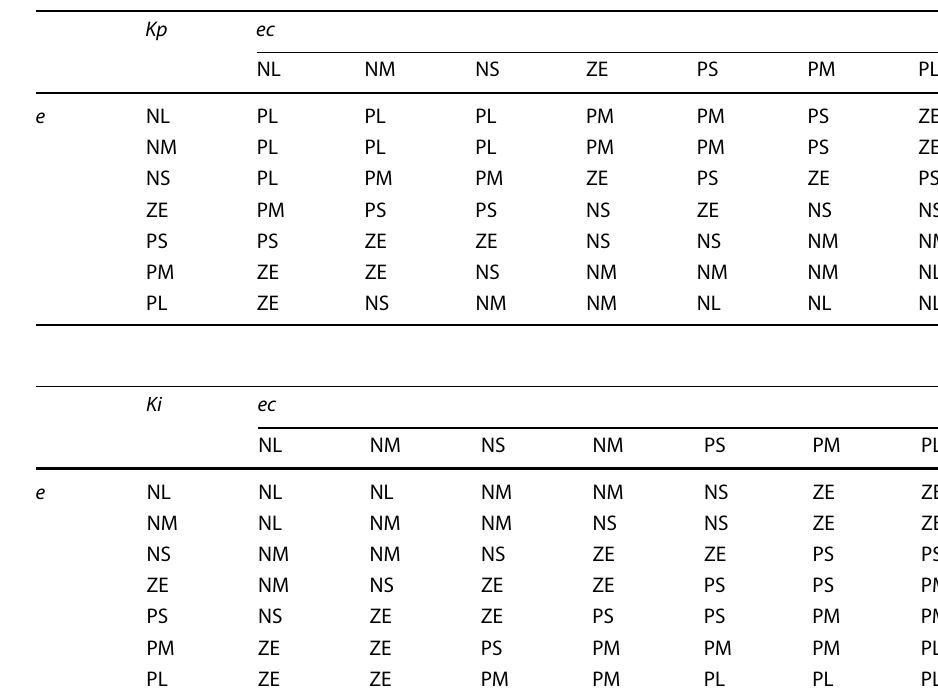
Table 1 Fuzzy rule list for Kp and e , ec